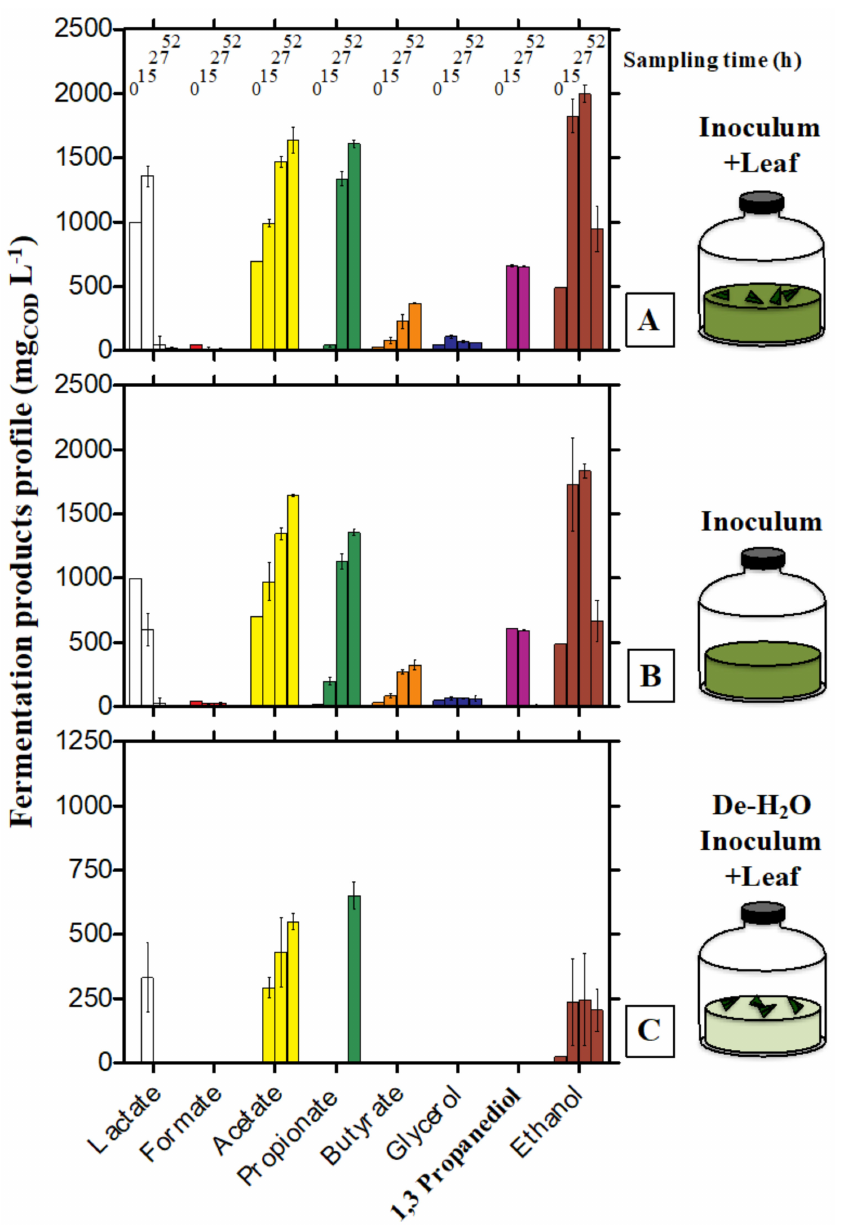
Figure 3. Accumulation of fermentation products in In vitro tests inoculated with gut microbiomes from giant panda fecal samples, namely: ( A ) Inoculum + Leaf; ( B ) Inoculum; and ( C ) De-H 2 O inoculum + Leaf. Keys reported in the